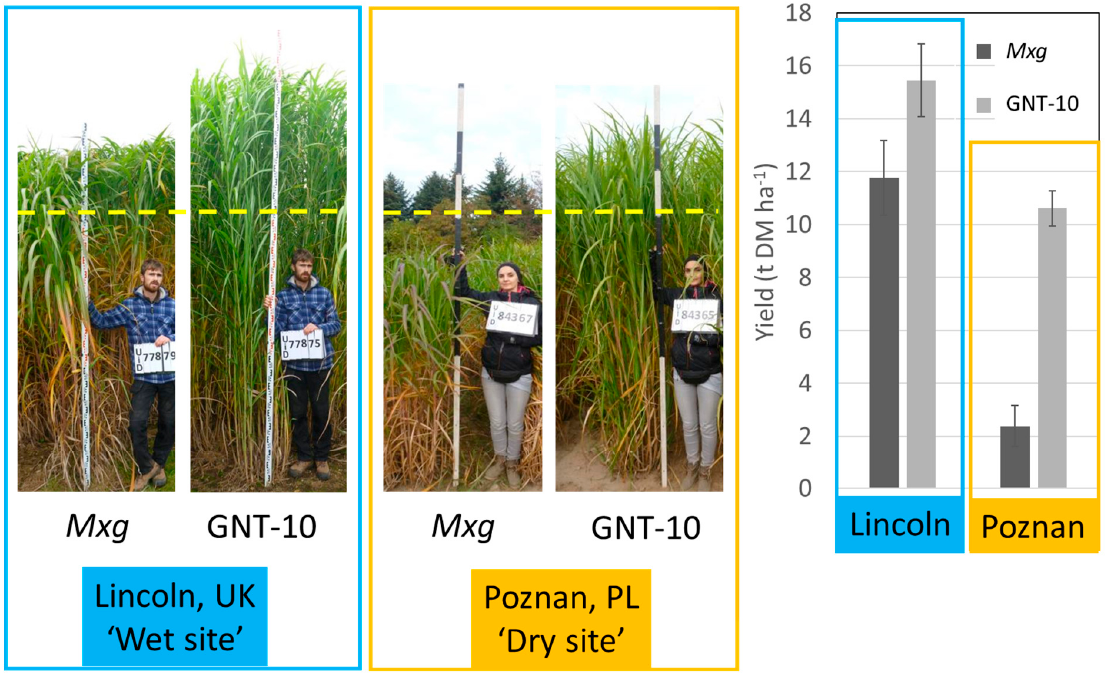
Figure 6. A side by side comparison of average yield in years two and three combined for a novel clonal hybrid ‘GNT-10’, from the breeding programme at Aberystwyth, and the commercial standard M × g . Plants were grown in replicated plot trials in Poznan (Poland) and in Lincoln (UK), photos are of the second (PL) and third (UK) years following planting respectively. In Poznan, there were long drought periods with soil moisture deficits below 200mm for several weeks in the growing seasons, the resulting growth in M × g was severely restricted. In Lincoln, there was adequate water supply and M × g performed as expected but was still out-yielded by GNT-10. A yellow dotted line shows 2m above ground level. Error bar = +/ − 1 SE.